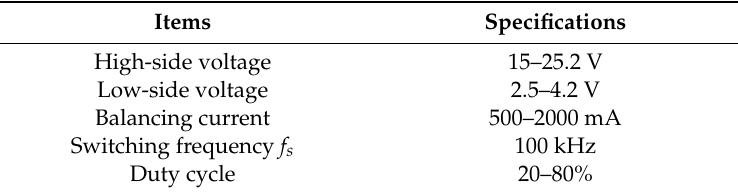
Table 1. Related parameters of the bidirectional flyback